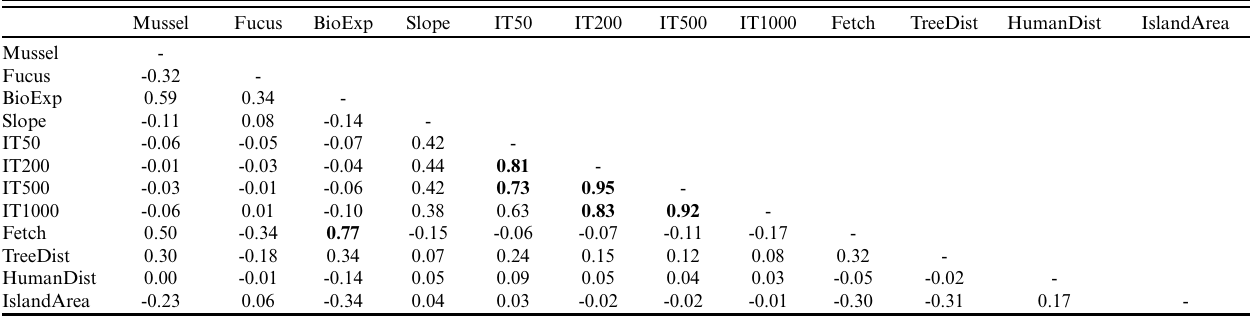
Table 2 . Pairwise Spearman correlation coefficients ( rho ) for ordinal and continuous predictors. Pairwise predictors with rho > 0.7 are shown in bold. BioExp Slope IT50 IT200 IT500 IT1000 Fetch TreeDist HumanDist